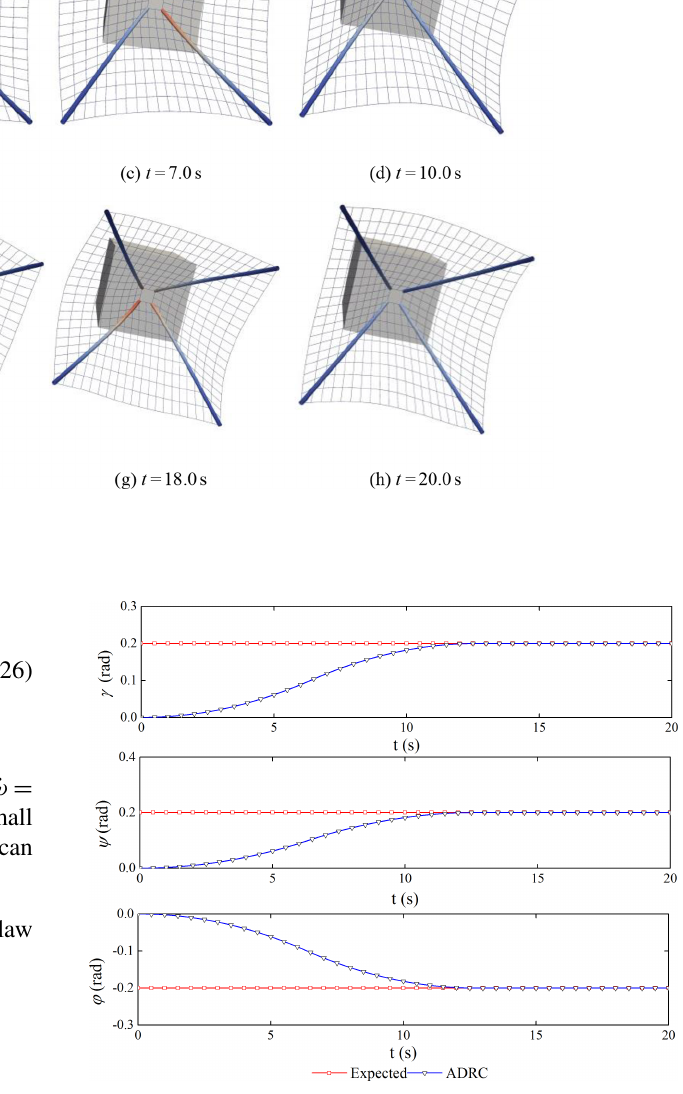
Figure 16. Attitude-tracking curve.